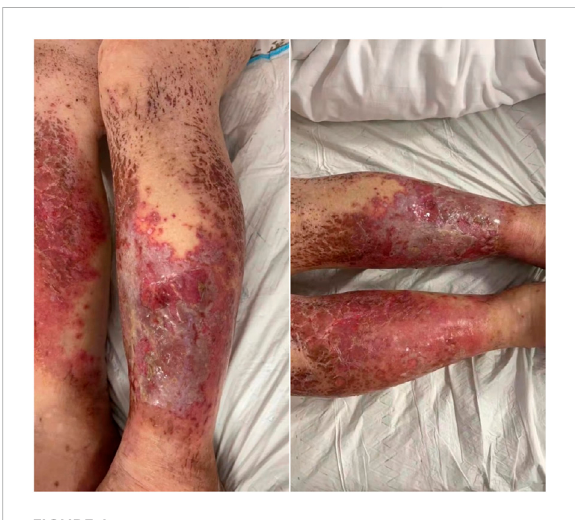
FIGURE 1 Skin appearance 4 weeks after the onset of skin